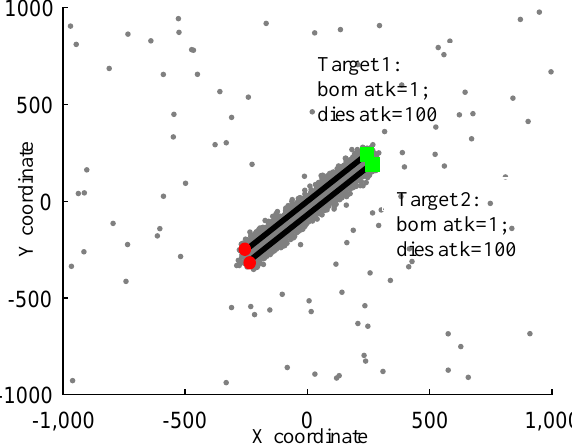
Figure 8. True tracks and measurements with clutter. Green square is the beginning point of the track; red circle is the end point of the track.